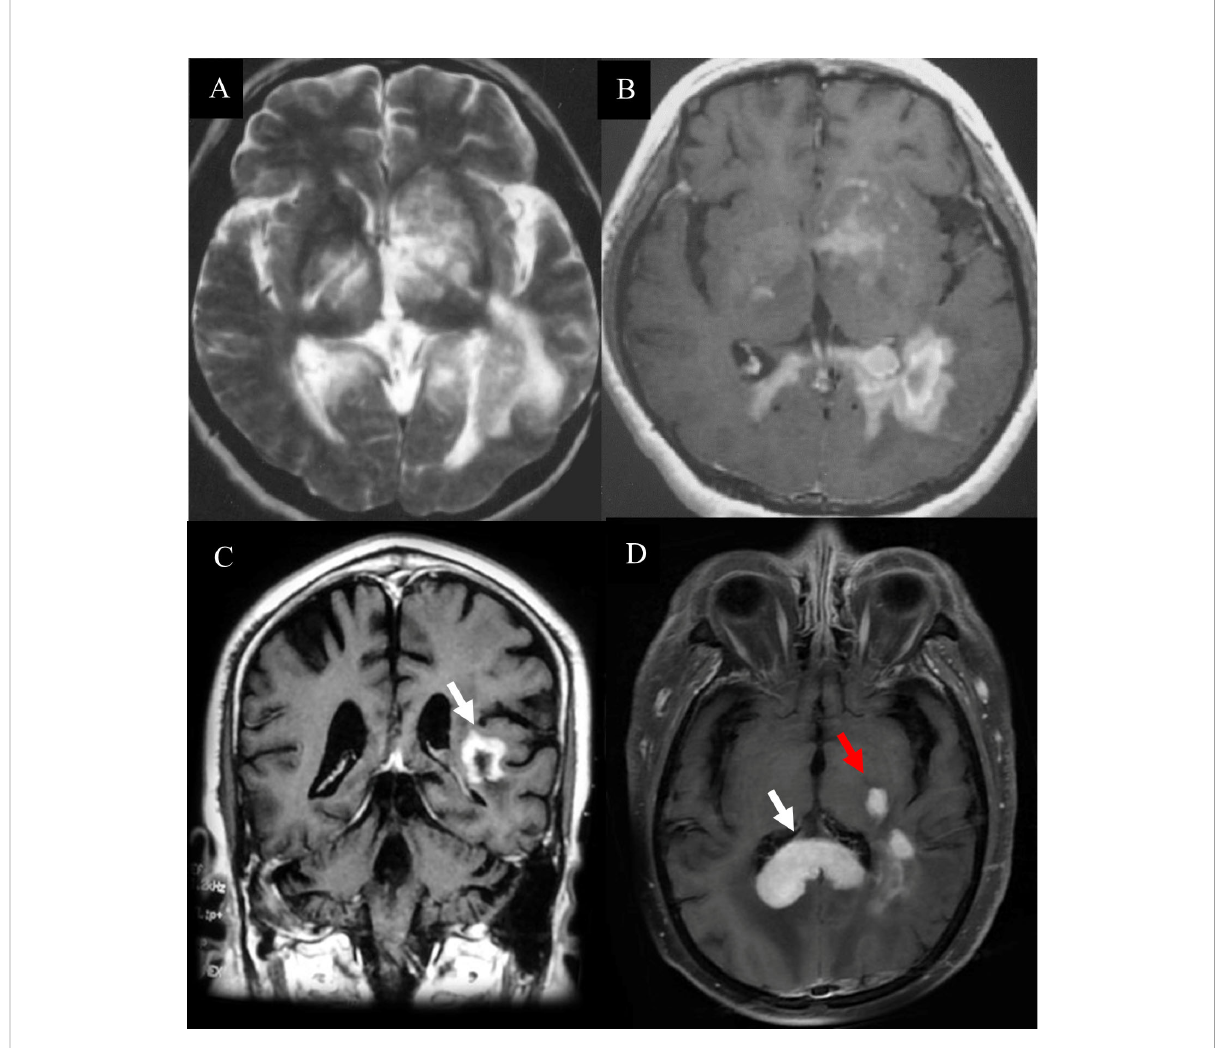
FIGURE 3 Hyperintense lesions in PCNSL. (A) The diffuse in fi ltrating lesions on T2 sequences. (B) The clump lesions with a ring-like enhancement. (C) The ‘ C ’ opening was not toward grey matter which differentiated from TDLs. (D) “ kidney type ” (White arrow) and “ raindrop ” -like (Red arrow) enhancement with thickened corpus callosum, while the lesions of TDLs without thickened corpus